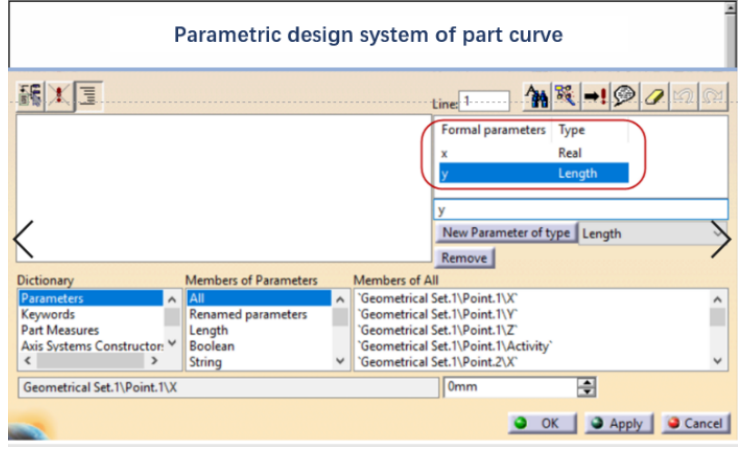
Fig. 8 Curve-type selection interface.